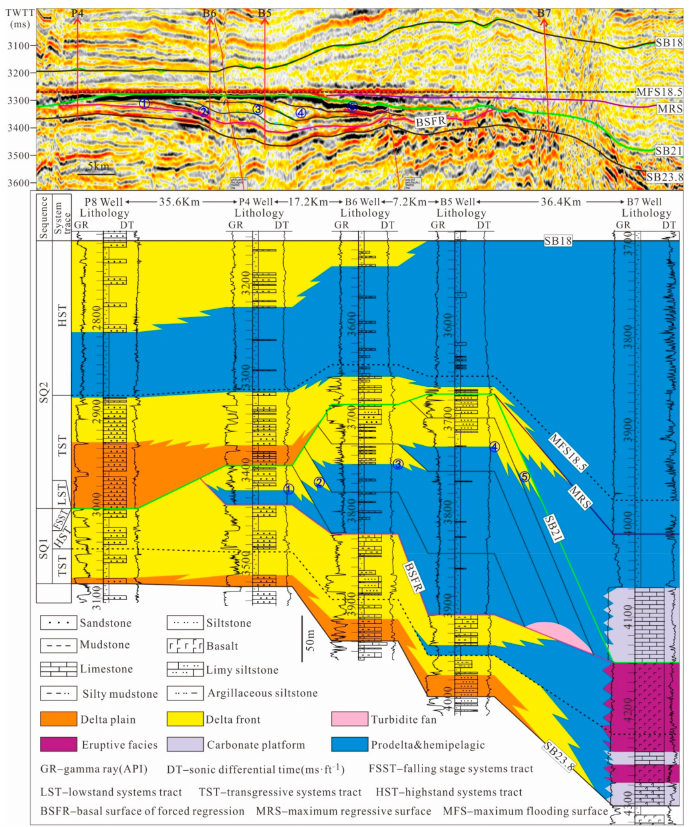
Figure 7. Correlation of wells illustrating the depositional sequences in the Zhujiang Formation of Panyu low uplift and Baiyun sag, Pearl River Mouth Basin (location of section is given in Figure 1B). Because of the gradient of the continental slope which may be different at different localities in the same area and the influence which are caused by the location of the main stream of the delta deposits, the sedimentary diversity of the falling stage systems tract under the shelf slope break may be more remarkable in the vertical depositional